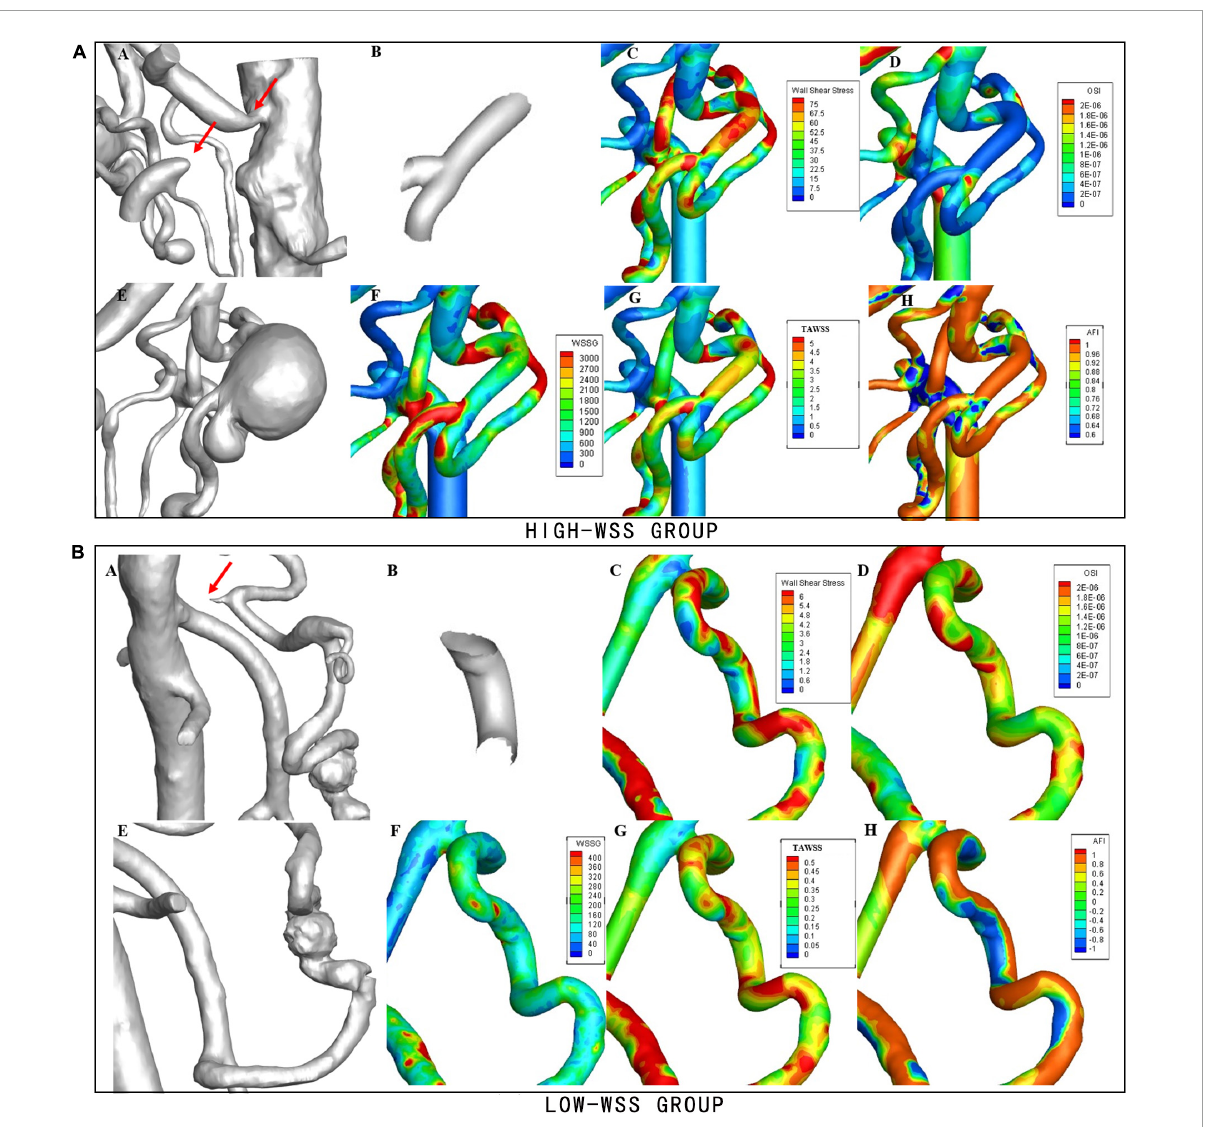
FIGURE3 Examples of hemodynamic parameters in the high-WSS and low-WSS aneurysms. (Upper panel) AN example from the high-WSS group. (A) Concurrent stenosis of CA and occlusion of SMA. (B) Aneurysm forming area. (C) Results of WSS. (D) Results of OSI. (E) Aneurysm located at the bifurcation of PDA. (F) Results of WSSG. (G) Results of TAWSS. (H) Results of AFI. (Lower panel) An example from the low-WSS group. (A) Stenosis of CA. (B) Aneurysm forming area. (C) Results of WSS. (D) Results of OSI. (E) Aneurysm located on PDA. (F) Results of WSSG. (G) Results of TAWSS. (H) Results of